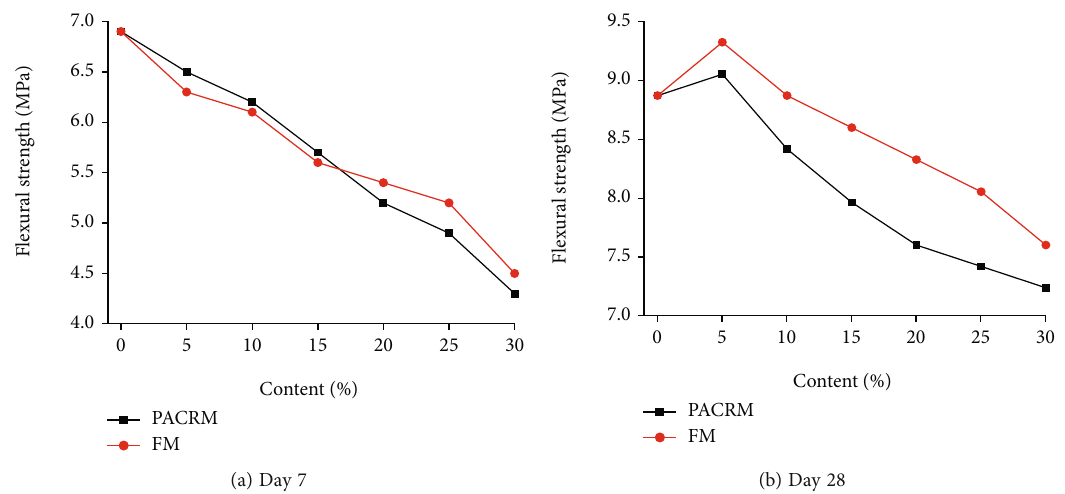
Figure 8: Flexural strength of cement mortar mixed with PAC waste residue and fl y ash.